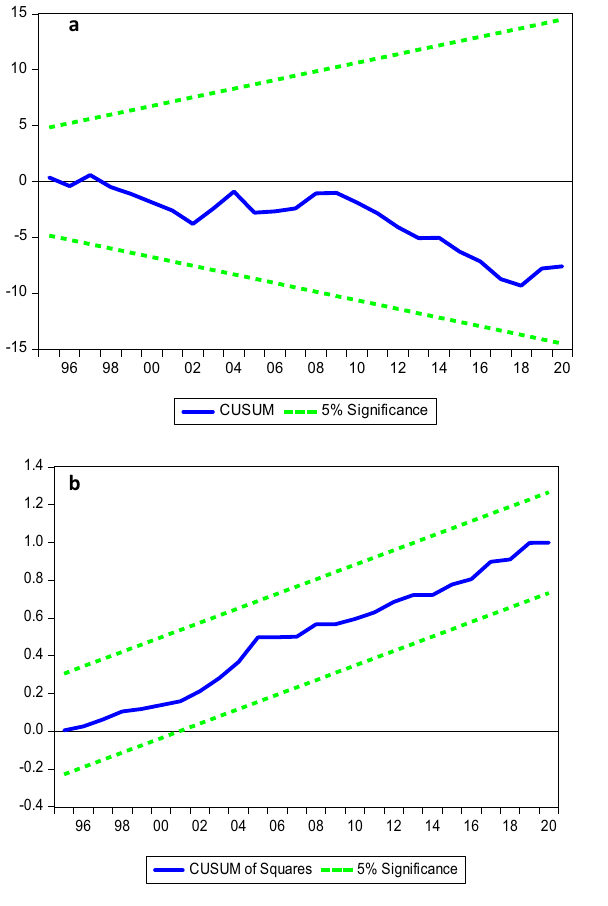
Figure 4. ( a ) CUSUM, ( b ) CUSUM of